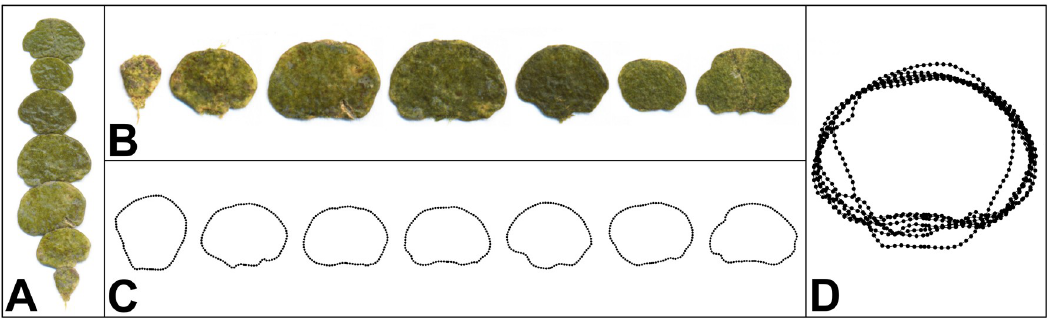
Fig 1. Branch of Halimeda tuna and the outline registration of segments. (A) Branch comprising seven consecutive segments. (B) Separated segments. (C) Semilandmarks digitized along the outlines. (D) Segments superimposed using generalised Procrustes